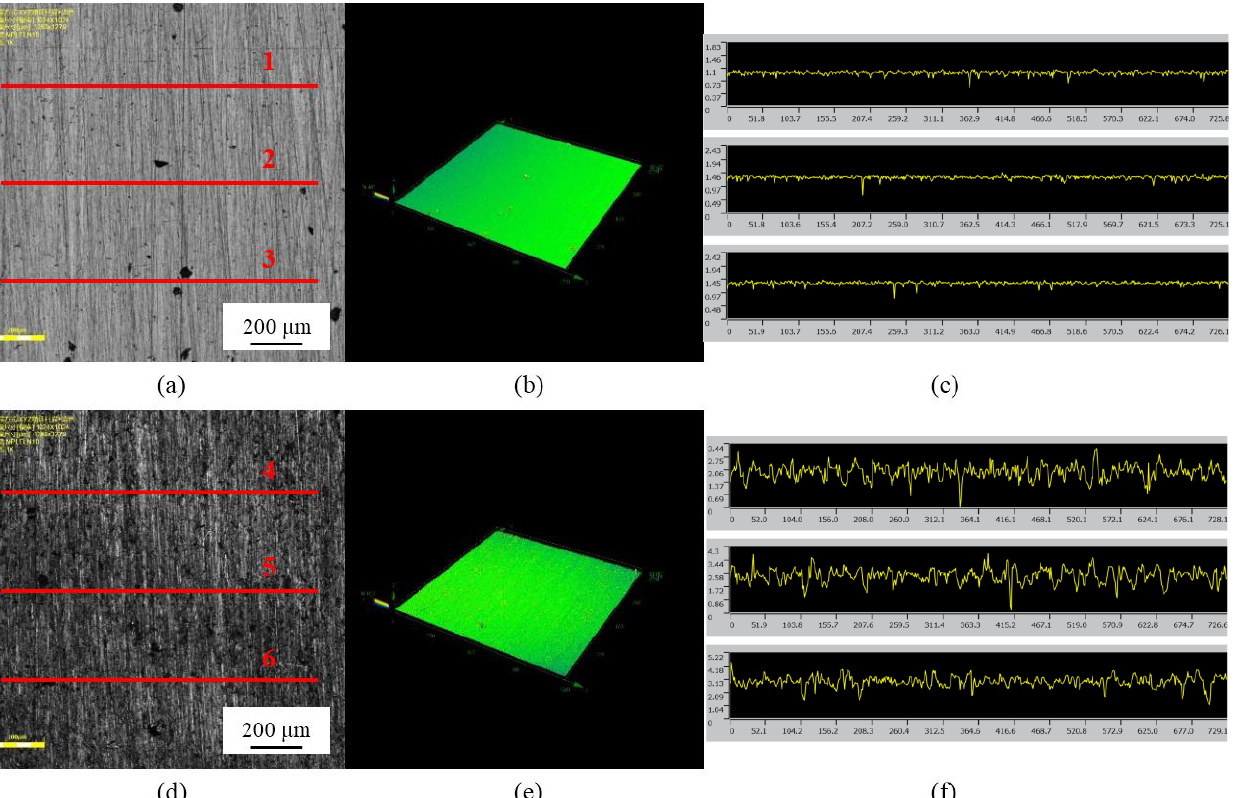
Table 3. Surface roughness of the substrate prior to coating deposition.